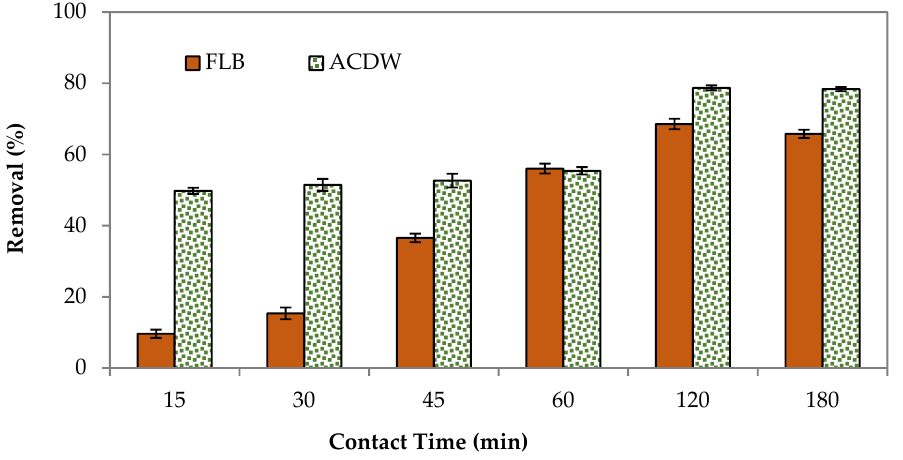
Figure 6. Influence of contact time on elimination efficiency of IV2R dye.